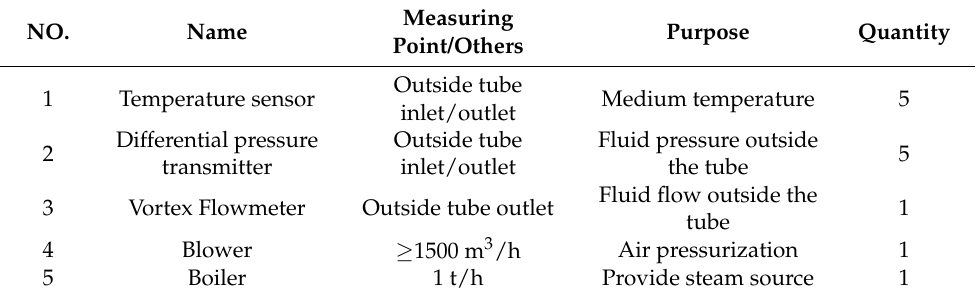
Table 1. Main instruments used in the test.